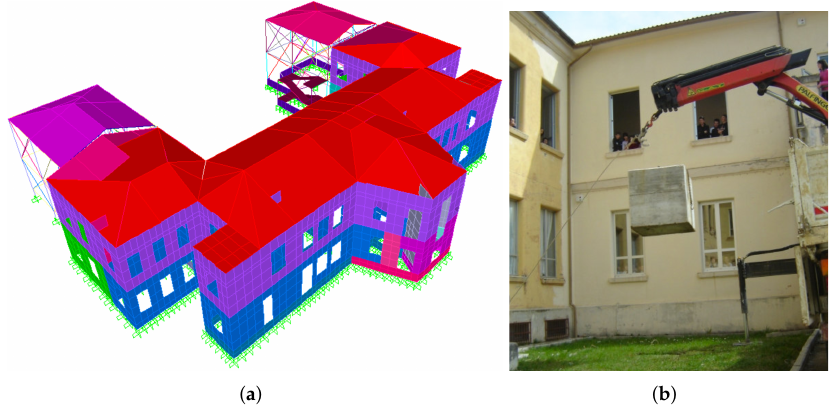
Figure 6. ( a ) View of the FEM. ( b ) Vibration excitation after the monitoring system installation with a RC weight falling on the